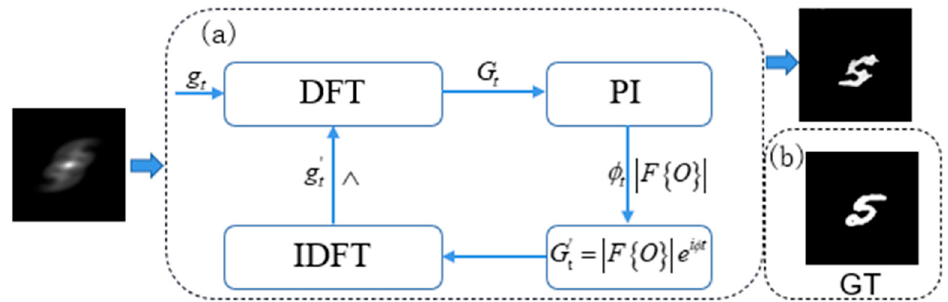
Figure 2. Flow of phase-recovery algorithm: ( a ) phase-recovery algorithm flow and ( b ) the ground truth. DFT is denoted as Discrete Fourier Transform, PI as Phase Information, and IDFT as Inverse Discrete Fourier Transform.